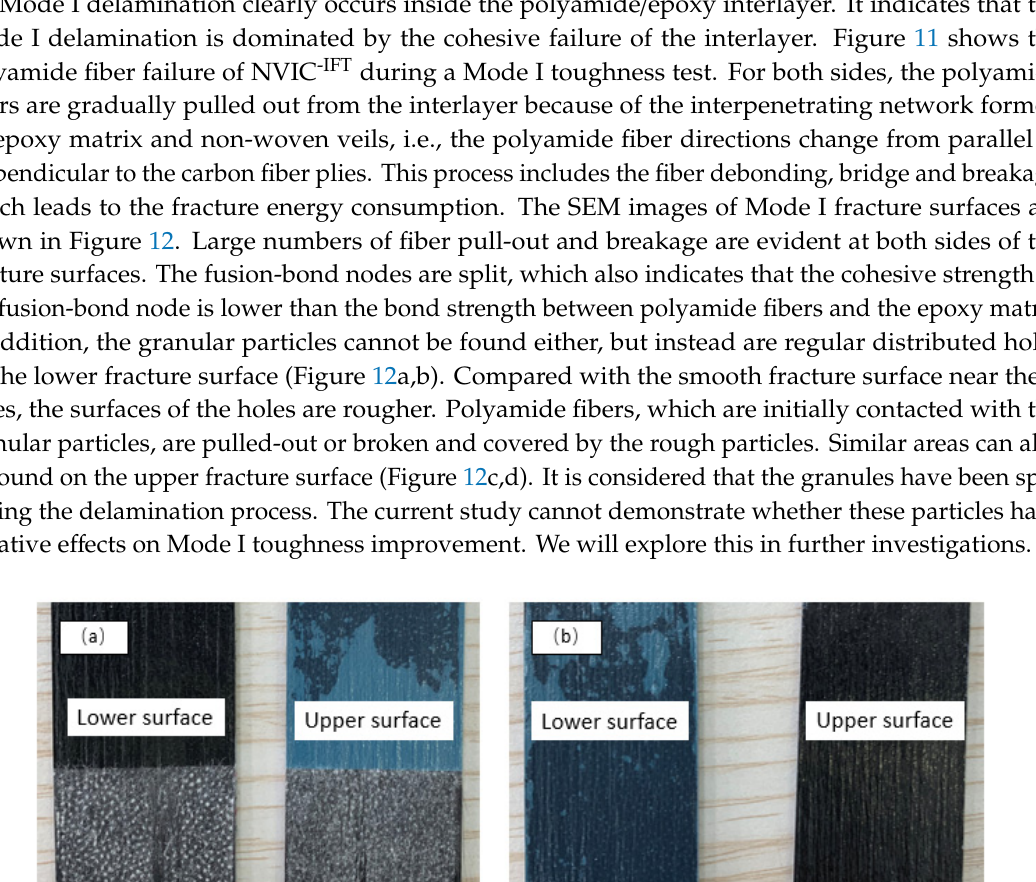
Figure 11. Failure mode of NVIC -ILT in DCB test. ( a ) side view, ( b ) through open mouth.